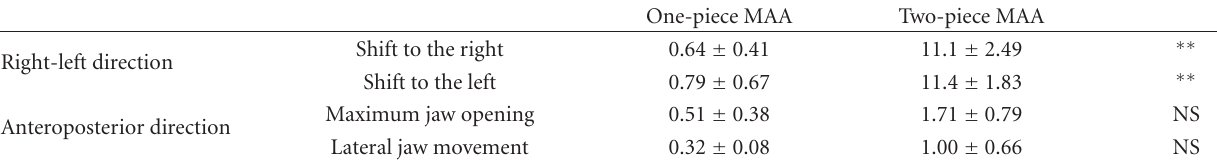
Table 1: The distance of mandibular movement with di ff erent MAAs during maximum voluntary e ff ort. One-piece MAA